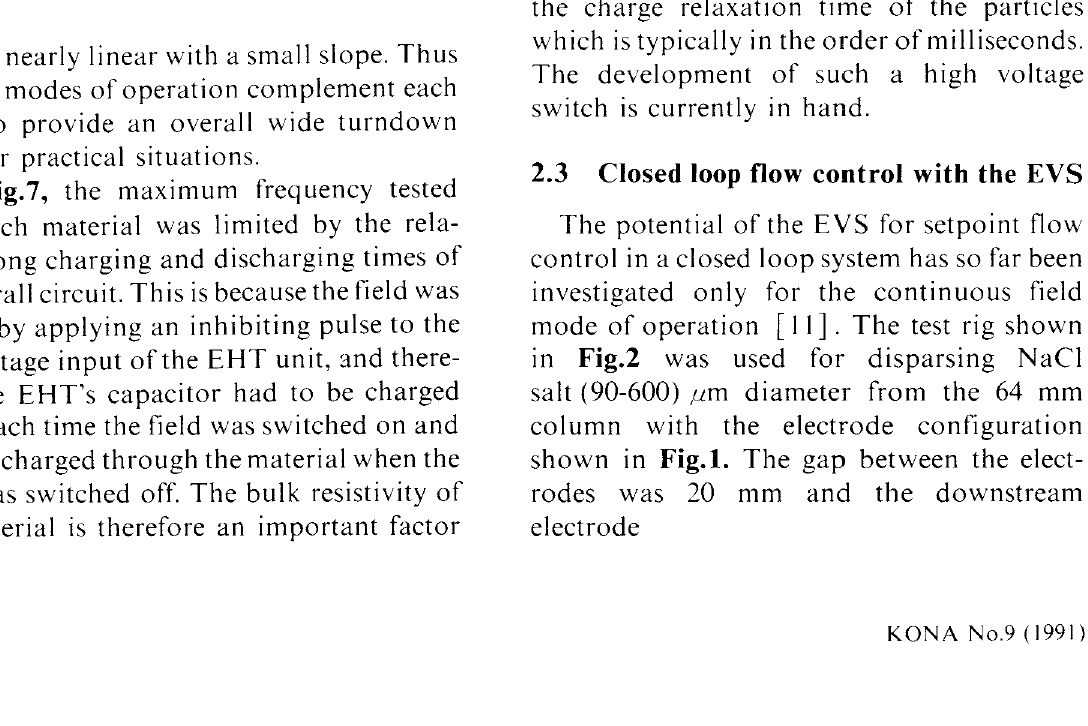
Fig.7 Effect of pulse frequency on flowrate for pulsating field operation in rectangular column. Pulse width=50r~o of period. Upper electrode~ 1-2 mm long pins spaced 10 mm apart; lower electrode~slots of5 mm width; IEG=20 mm. •: turnip seeds( 1.2-1.7 mm). pulse amplitude= 3.5 kV;6: sand (0.6-0.85 mm). pulse amplitude= II kV; c :salt(0.35-0.6 mm). pulse amplitude~ 12 kV.